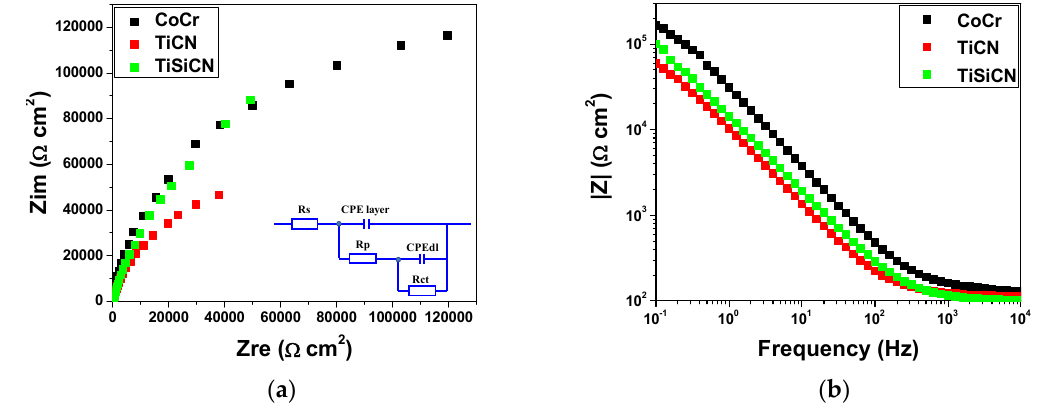
Figure 5. ( a ) Nyquist plot (electrical circuit used for the fitting procedure included) and ( b ) Bode plot of the investigated specimens.